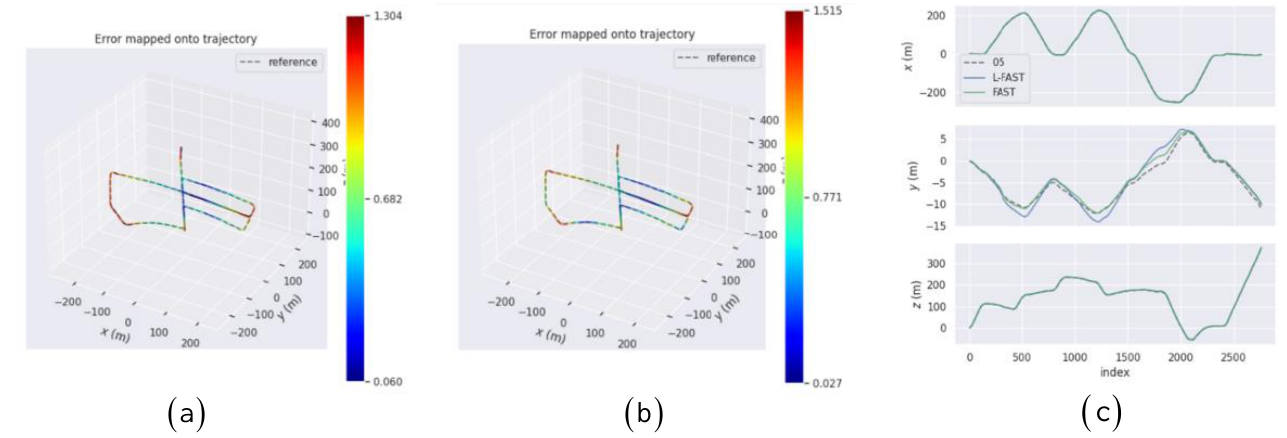
Figure 11. The motion trajectory (( a ) is FAST and ( b ) is L-FAST) and error comparison ( c ) diagrams of two algorithms.